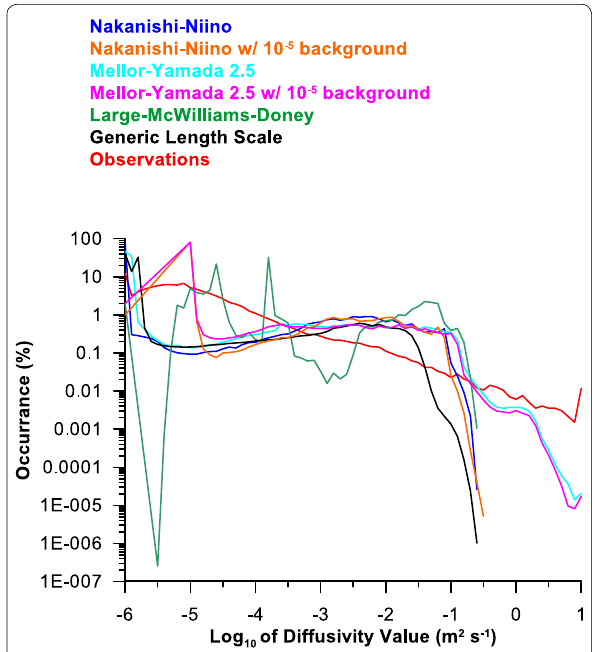
Fig. 4 The distribution of the temperature diffusivities for the observations (red), Nakanishi – Niino (blue), Mellor – Yamada 2.5 (cyan), Large – McWilliams – Doney (green) and GLS (black) mixing schemes on log